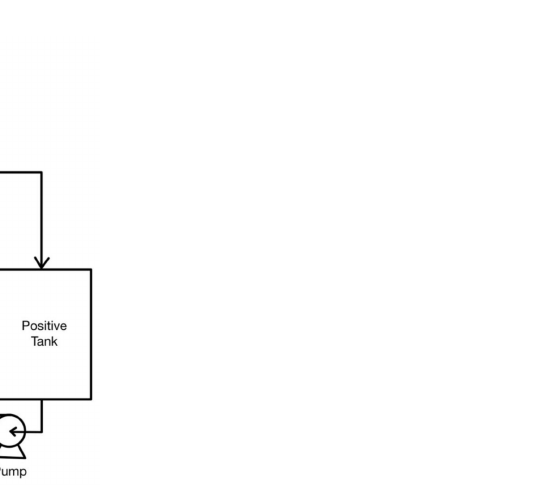
Figure 5. Basic configuration of the vanadium-redox system which consists of electrolyte tanks (posi- tive and negative), stacks, endplates, and pumps [15]. No changes were made to the original